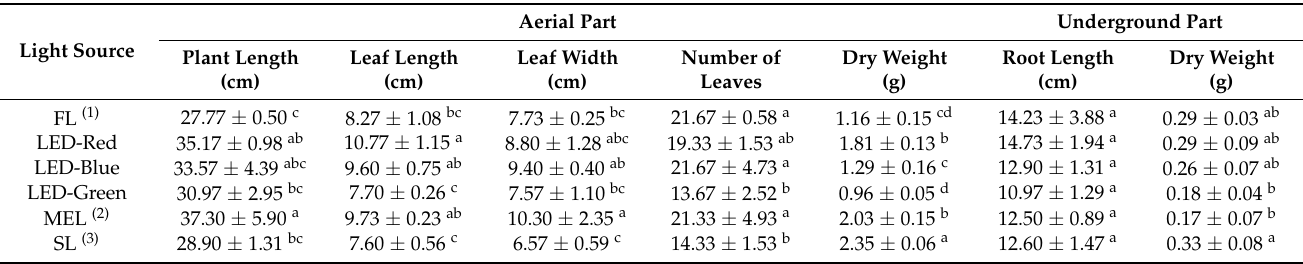
Table 1. Growth characteristics by parts of aerial and underground in A. macrocephala treated with artificial light sources for 2